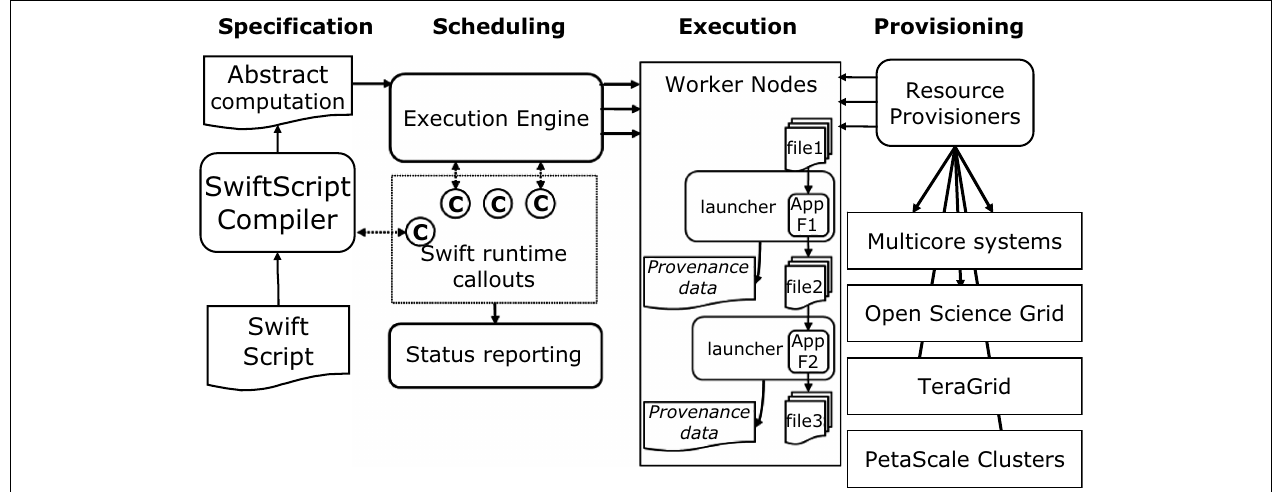
FIGURE 2 | Swift architecture: Managing workfl ow execution within CNARI. Specifi cation and scheduling are implemented on the client side while execution is implemented on the remote computing resources.